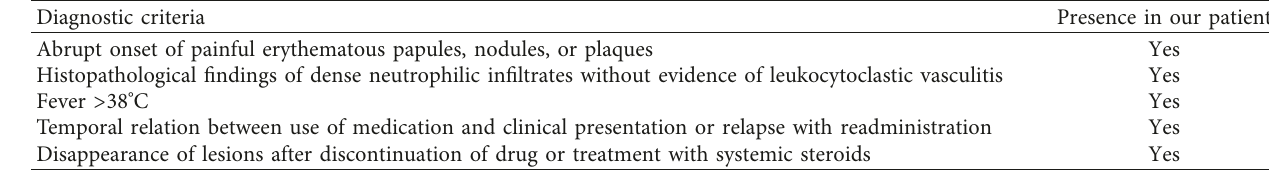
Table 3: Diagnostic criteria for drug-induced Sweet’s